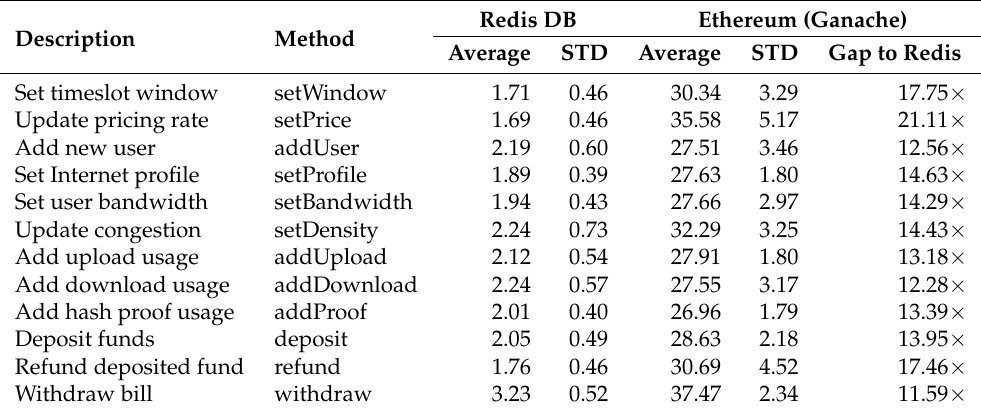
Table 8. Processing delay (in milliseconds) for writable operations in RealPrice when implemented as non-blockchain (Redis DB) and blockchain (Ganache) approaches.